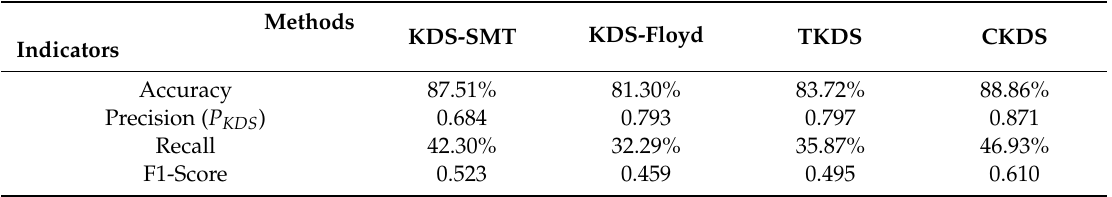
Table 1. The evaluation indicators of three classical methods compared with CKDS.